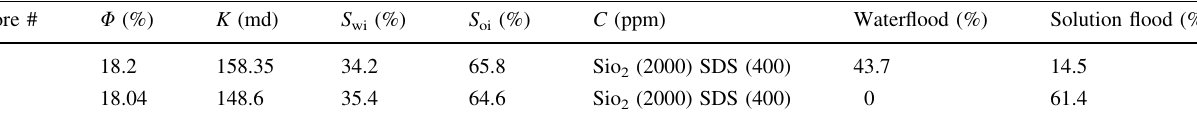
Table 8 Oil recovery of water and nano-flooding (cores 8 and 9)